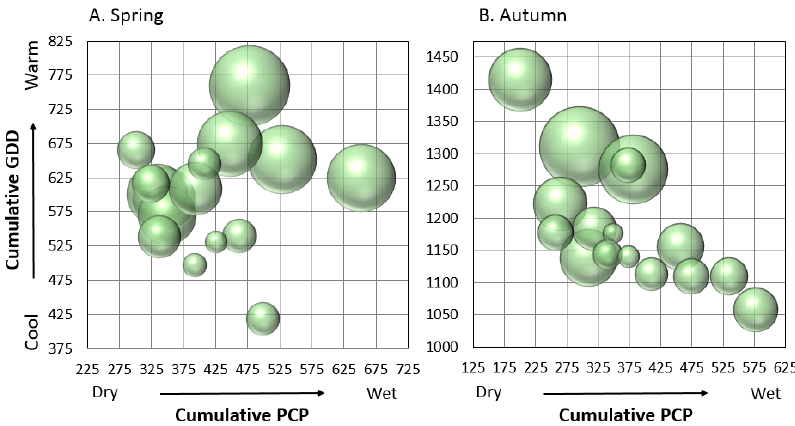
Figure 8. Relative mean spring and autumn NDVI for pure hardwood forests between 610 and 1220 m (2000–4000 ft.) elevation, 2000–2015, compared to cumulative growing degree days (GCC) and cumulative precipitation in mm (PCP). Larger diameter circles had higher mean NDVI for: 16 May ( A ); or 31 October ( B ). Weather measures accumulate from: 18 February to 16 May ( A ); or 28 July to 23 October ( B ).